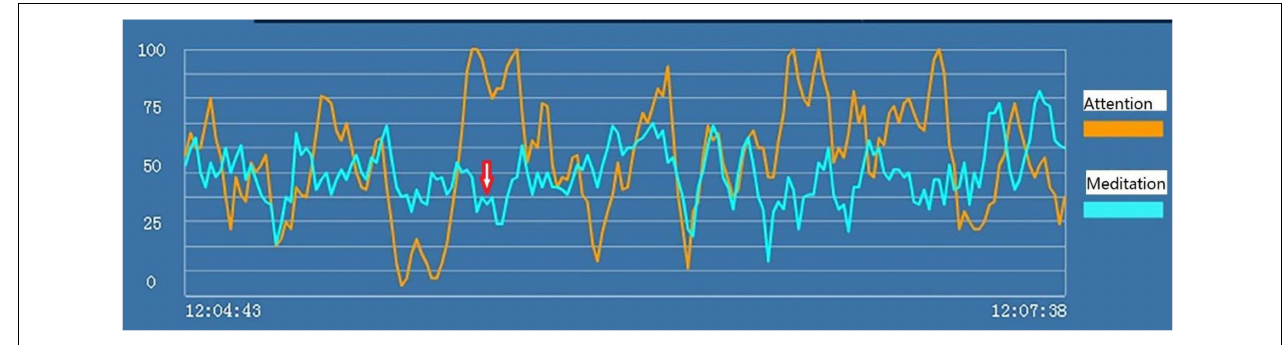
FIGURE 4 | “Attention” (the orange line) and “meditation” (the blue line) signals in the HTP drawing test for subject A4 who had state depression. The red arrow indicates the markers of state depression.